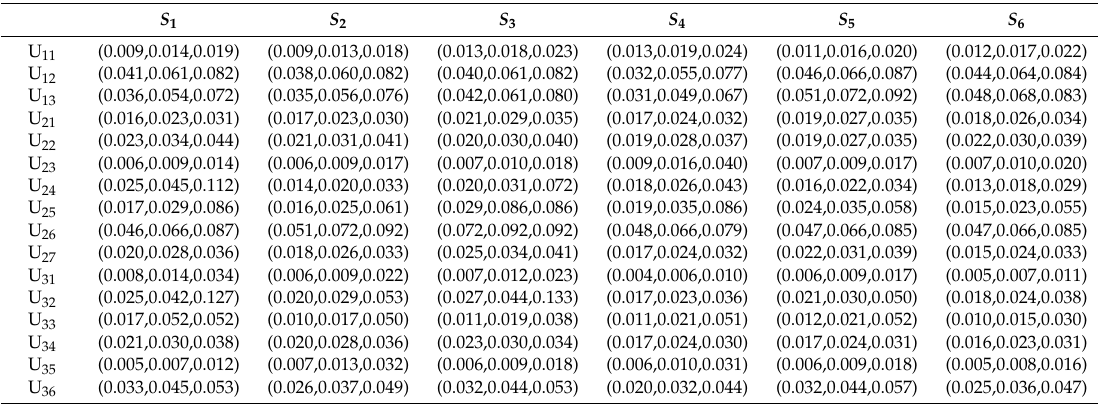
Table A3. The weighted normalized fuzzy decision